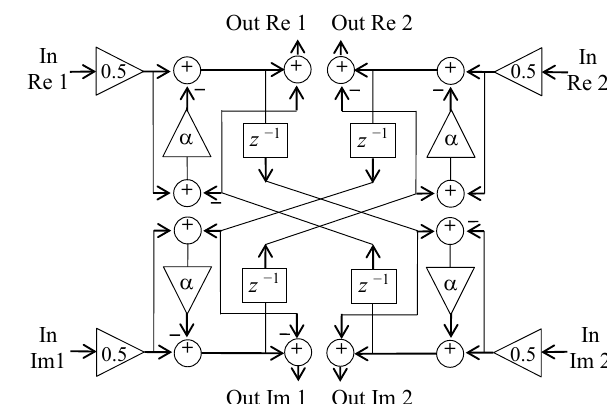
Fig. 6 Bilinear orthogonal bicomplex MHNS -based filter.